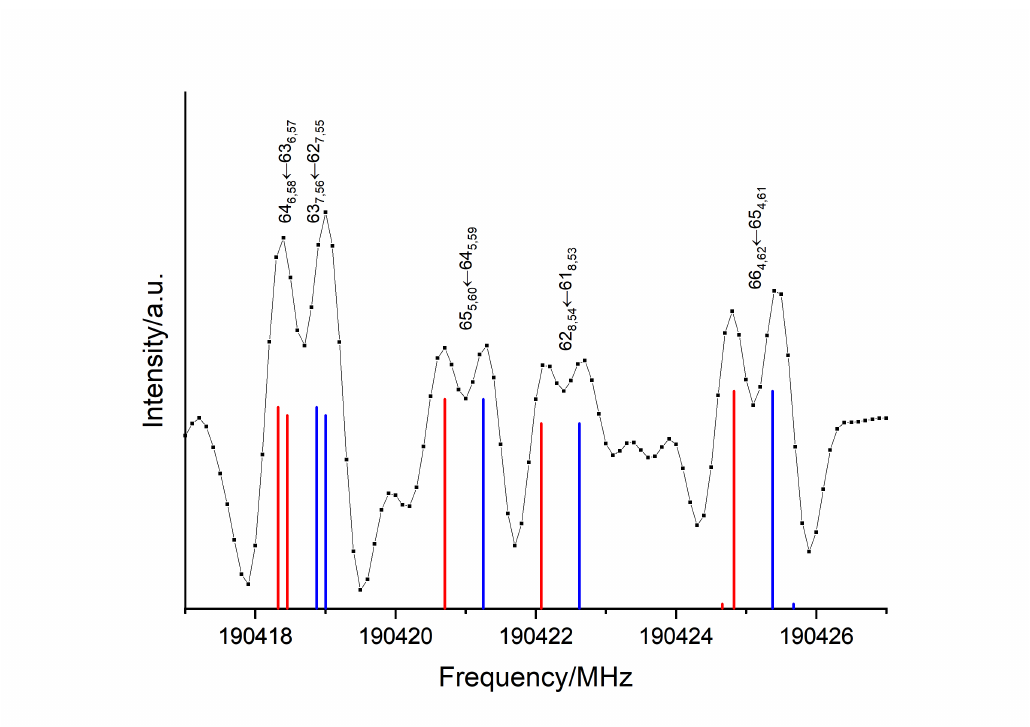
Figure 7. Tunnelling splittings observed in the pure rotational mm-wave spectrum within the | v = 1 (cid:105) ES. Each doublet associated with J (cid:48) 35 blue and red